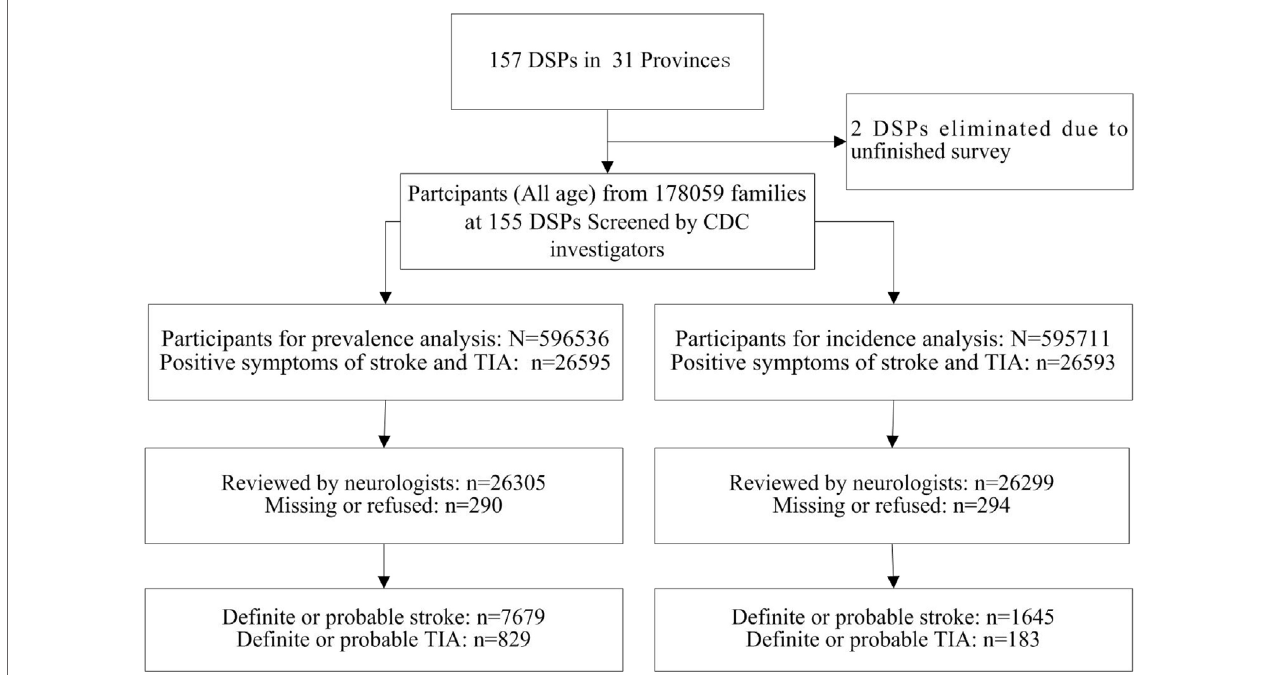
FigUre 2 | Flowchart for stroke and transient ischemic attack (TIA) case ascertainment. Note: DSPs, disease surveillance points; CDCs, centers for disease control and prevention.